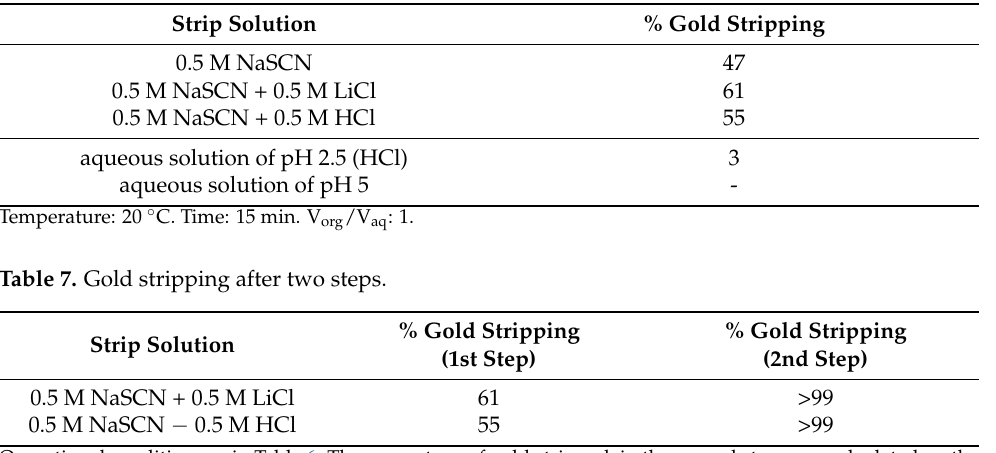
Table 6. Gold stripping using various strippants.